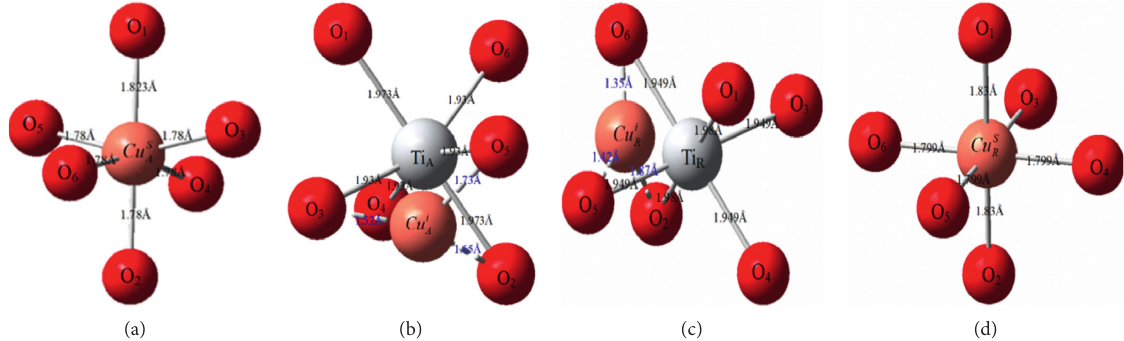
Figure 2: Cu-doped TiO 2 structure model; (a) Cu replaced substitutional sites in the anatase; (b) Cu occupied interstitial sites in the anatase; (c) Cu replaced interstitial sites in the rutile; (d) Cu occupied substitutional sites in the